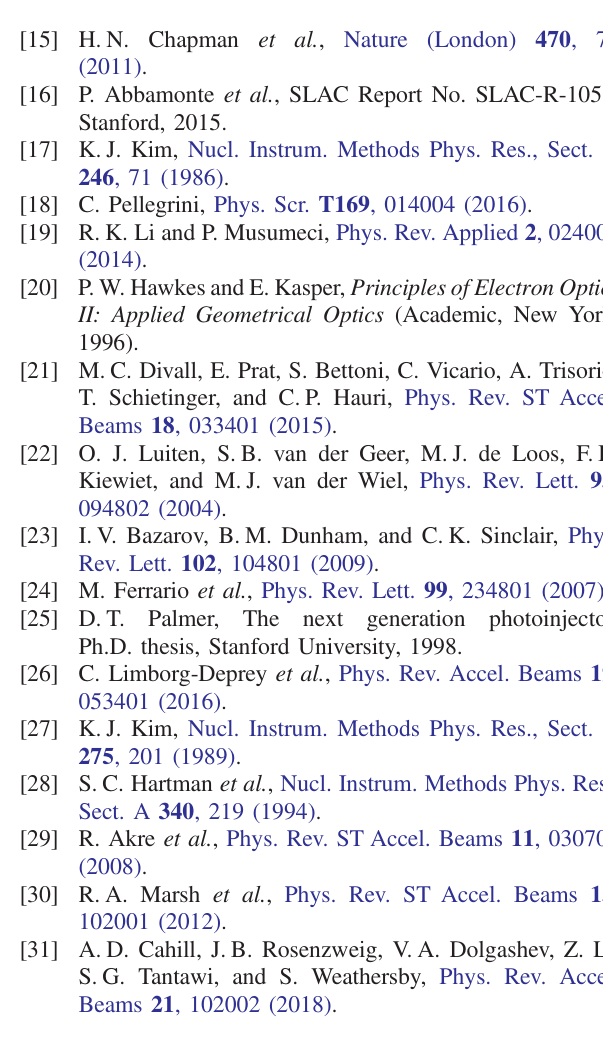
within the pulse of initial length τ , in the f